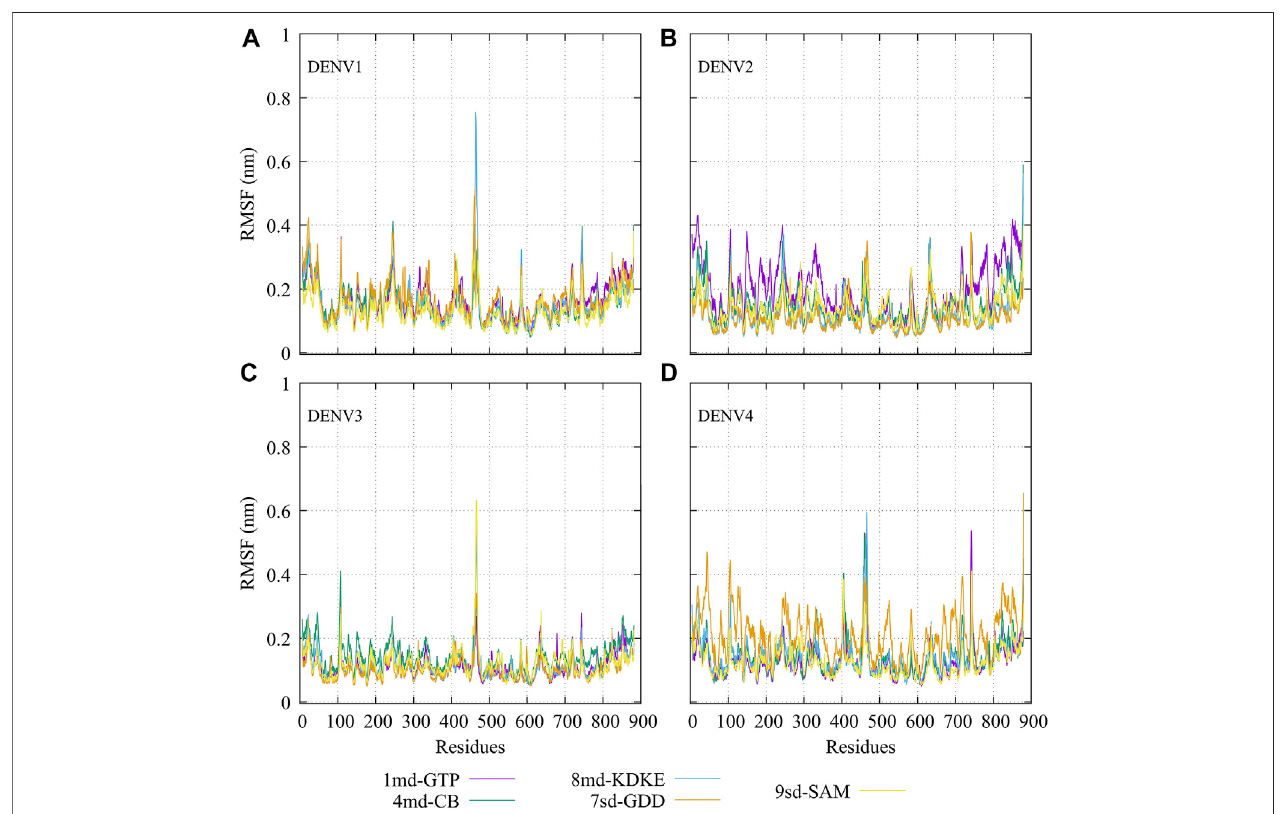
FIGURE 4 | RMSF as a function of numbers of residues for the protein – ligand complexes formed by the best compound of each binding site in (A) DENV1, (B) DENV2, (C) DENV3, and (D) DENV4.